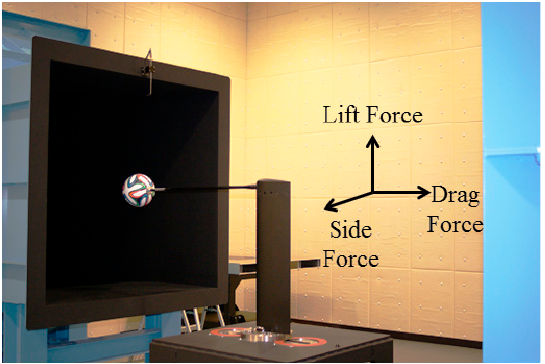
Figure 1. Wind tunnel setup showing a Brazuca soccer ball mounted on a support rod. Air flows from left to right. The directions of the aerodynamic force components are shown.